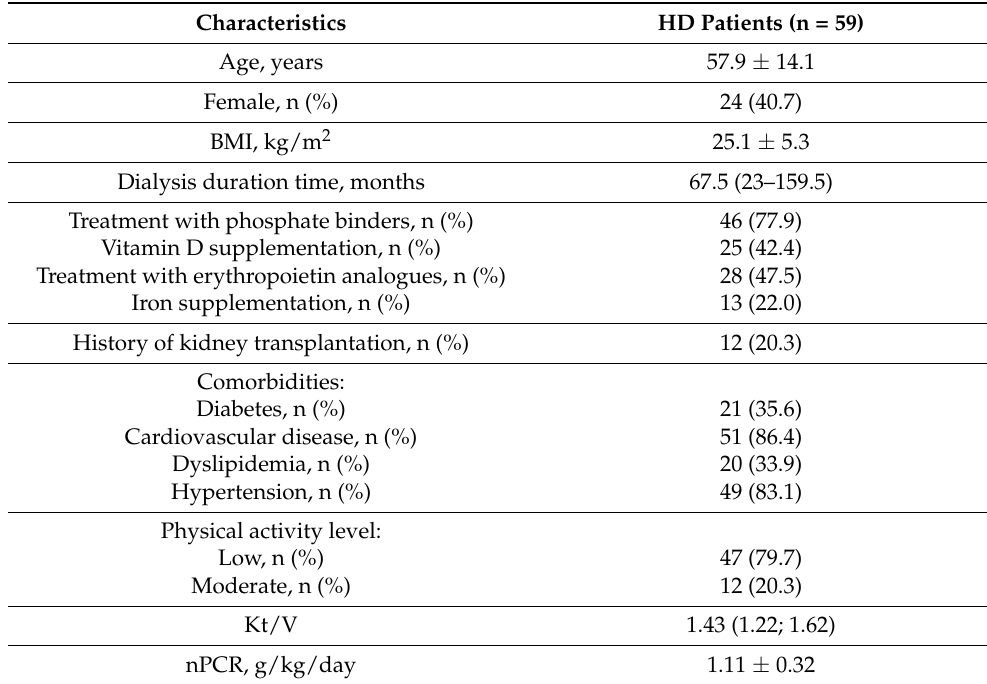
Table 1. Clinical characteristics and laboratory parameters of the study